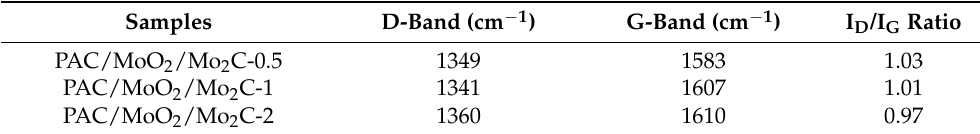
Table 1. Raman data of the PAC/MoO 2 /Mo 2 C ternary